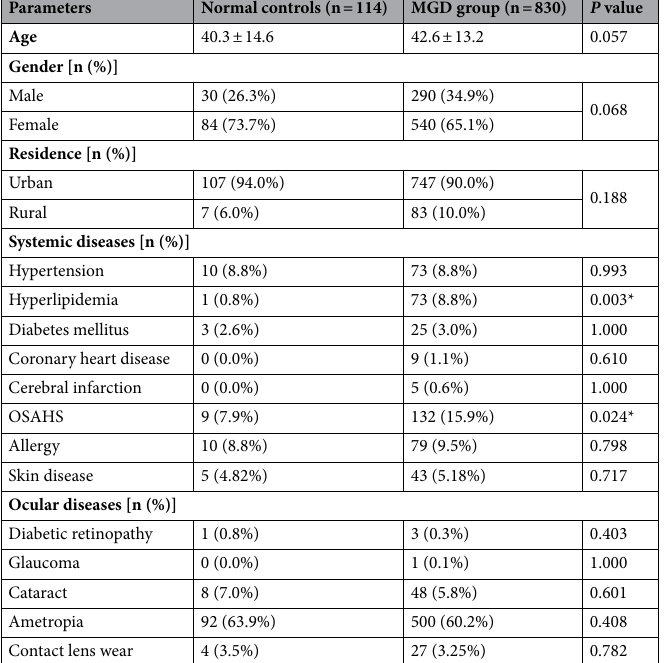
Table 1. Characteristics of MGD patients and normal controls. OSAHS obstructive sleep apnea–hypopnea syndrome. *P < 0.05 was considered statistically